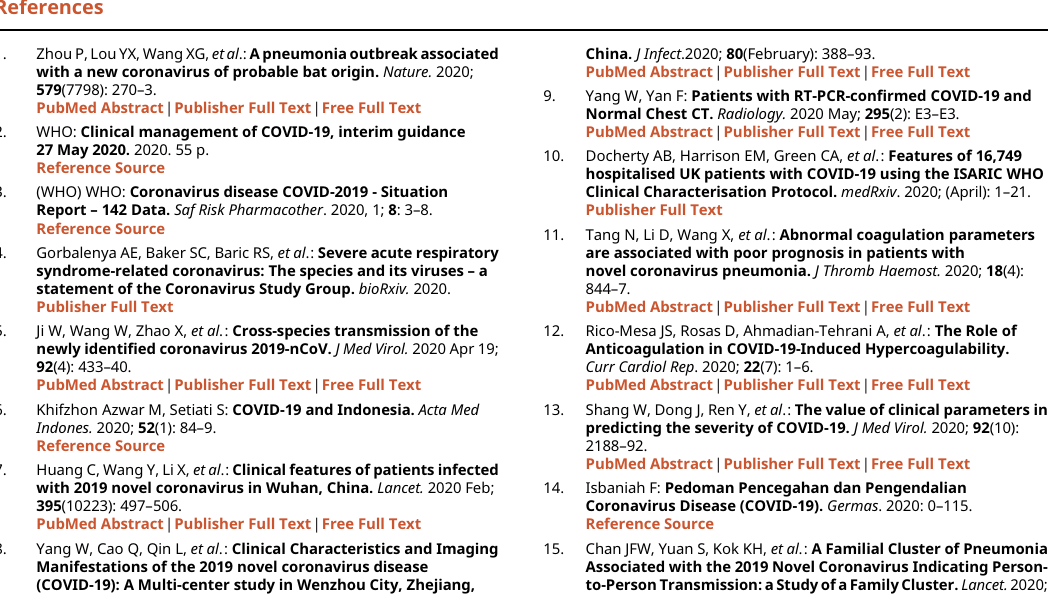
Figshare: Underlying data for ‘ Hematologic and coagulopathy parameter as a survival predictor among moderate to severe COVID-19 patients in non- ICU ward: a single-center study at the main referral hospital in Surabaya, East Java, Indonesia ’ . https://doi.org/10.6084/m9.figshare.14673060. The project contains the following underlying